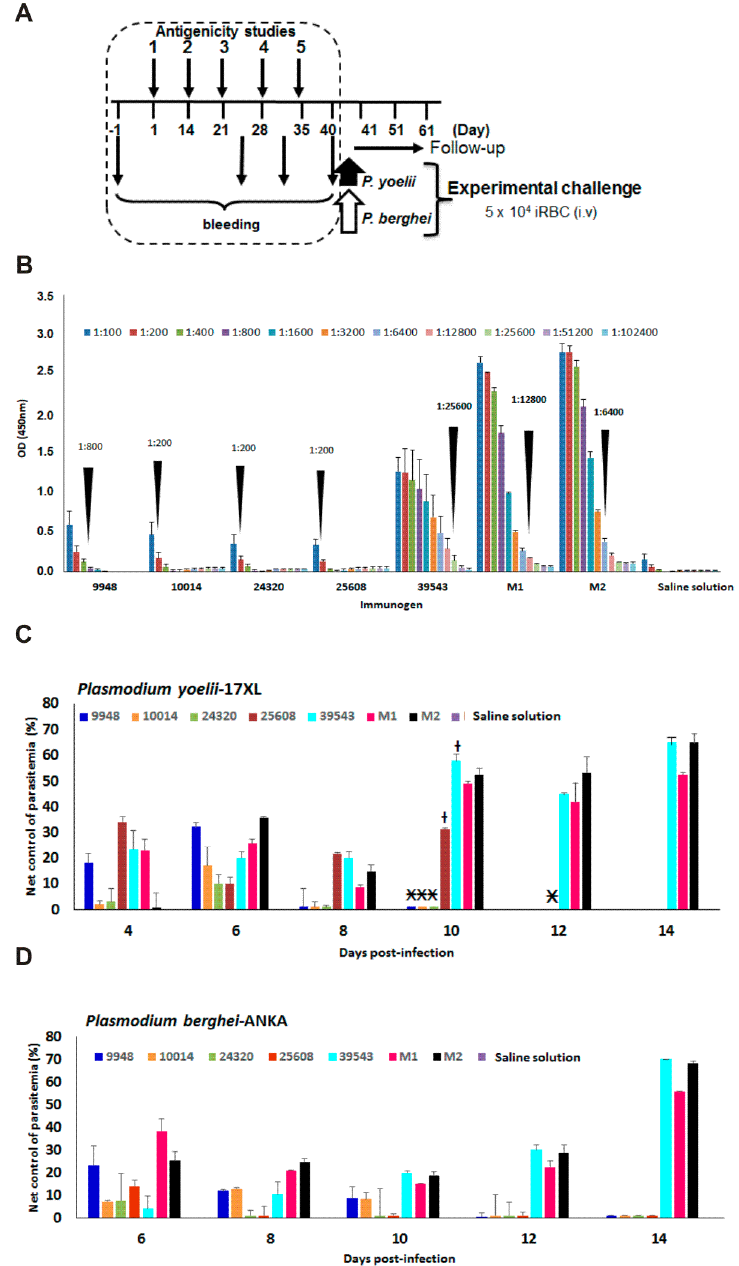
Figure 2. P. falciparum -based large chimera antigenicity and protection capacity. ( A ) A 5-dose immunization scheme consisted in a first dose and four boosts at days 14, 21, 28 and 35. Bleeding samples were obtained previously to the first vaccination and after the third, fourth and fifth dose. Malaria lethal challenging was conducted by i.v injection of 5 × 10 4 P. yoelii and P. berghei infected RBCs and parasitemia follow-up for a 60-day period; ( B ) Immunogen-formulations were 9948- Pf RESA, 10014-MSA1, 2430-STARP, 25608- Pf CSP, 39543 large-chimera, a mixture of the four single components M1 , a mixture of the four components in presence of the large-chimera M2 and saline solution for the placebo group. Antibody titers were defined as the sera highest dilution that still yields a positive reading expressed as the OD mean value at 450 mn produced by a given analyte sample minus twice the OD mean value of pre-immune sera ± SD; ( C ) Net control of parasitaemia of vaccinated mice experimentally challenged with P. yoelii 17XL and with P. berghei ANKA in ( D ). * spontaneous death and † mild symptoms.